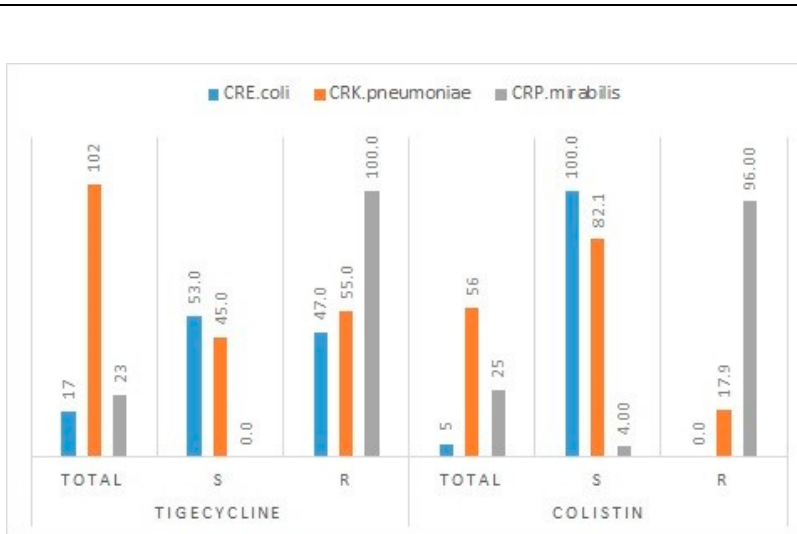
Figure 1. Tigecycline and colistin resistance in carbapenem-resistant E . coli , K . pneumoniae, and P . mirabilis (total in absolute numbers, and individual resistance in percentages).